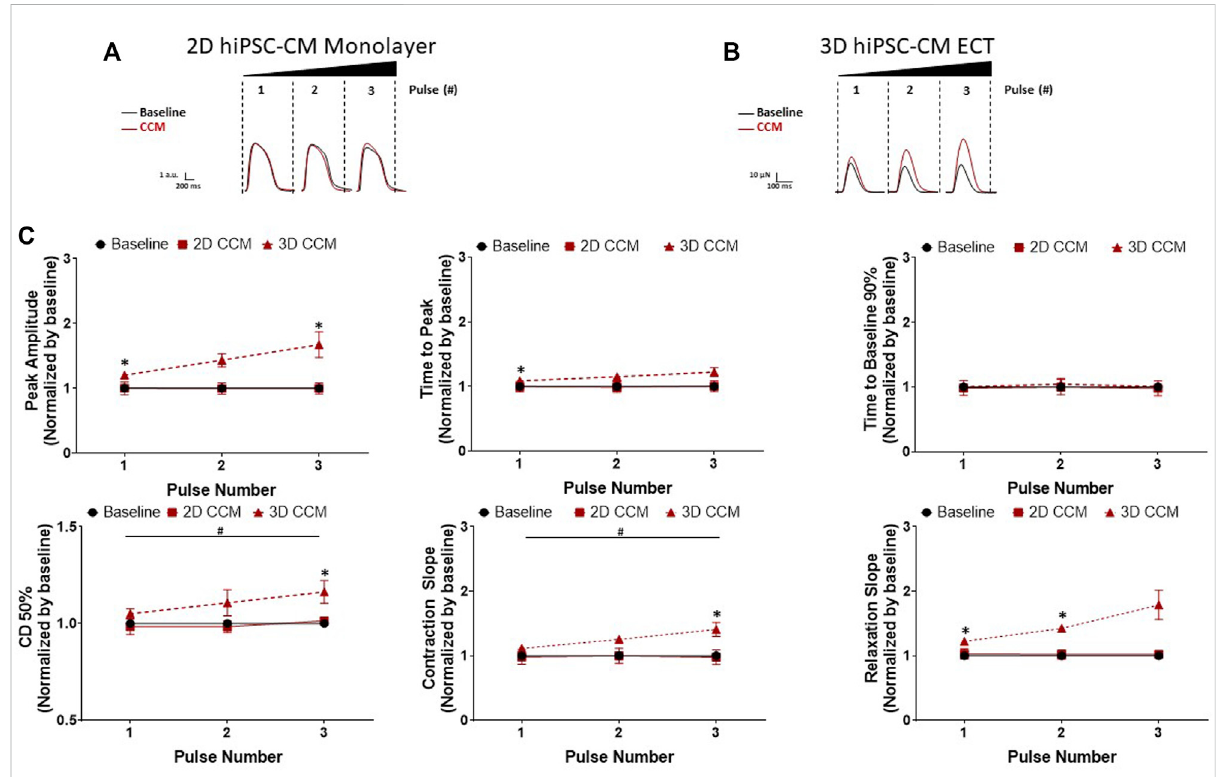
FIGURE 7 Effect of CCM pulse number on 2D and 3D hiPSC-CM contractile properties (A) Representative contraction traces for baseline (i.e., fi eld stimulation pacing, 1 Hz). and CCM for 2D monolayer hiPSC-CMs and (B) 3D ECTs (C) Summary data graphs. Data are mean ± SEM. n = 3 – 6 per group. * p < 0.05 (3D vs. BL), # p < 0.05 (3D vs. 3D), + p < 0.05 (2D vs.